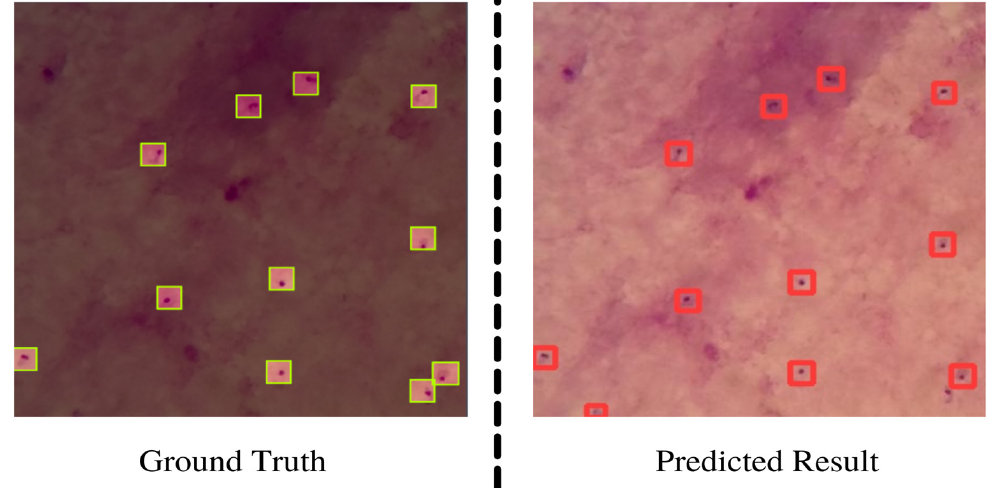
Figure 9. Comparison of Ground Truth and Predicted Result. The left image is taken from the dataset, and the right image is a prediction generated by the trained model. Green colored boxes are the labelled data and red color boxes represent the predicted data from final model.